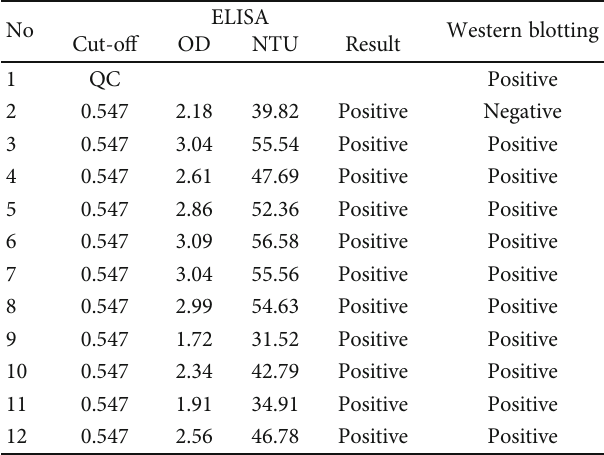
Table 1: Results of the anti- Toxocara canis -speci fi c antibody assessment.